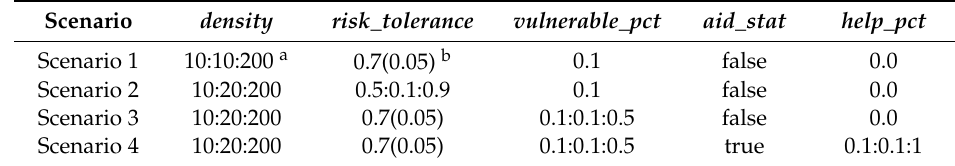
Table 4. Parameters Design for Four